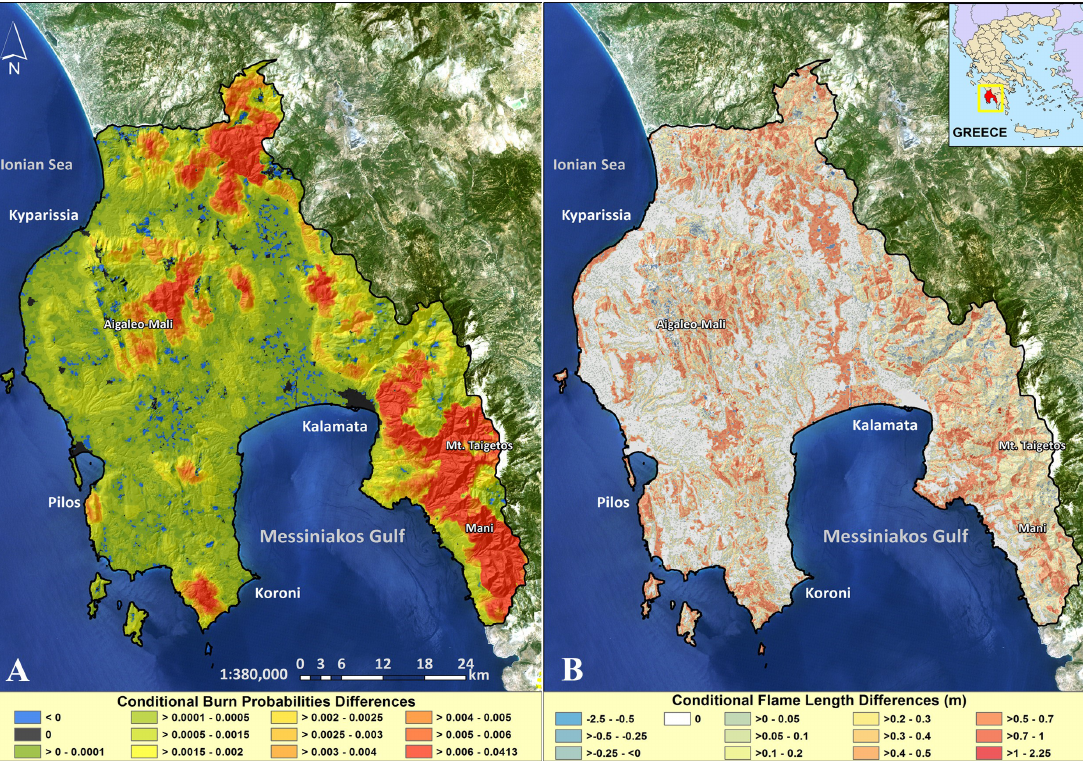
Figure 5. ( A ) Conditional burn probability and ( B ) conditional flame length differences of present and future time periods in Messinia,